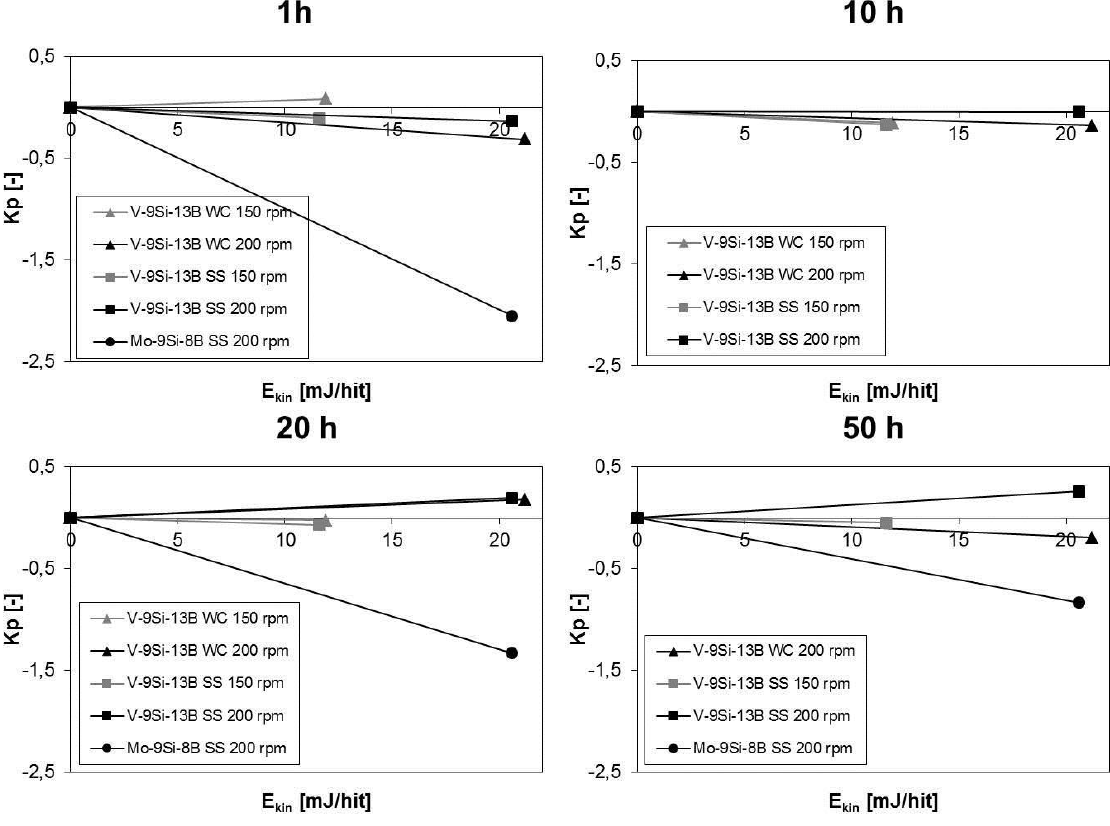
Figure 7. Comparison of the milling behavior of V-9Si-13B and Mo-9Si-8B alloys depending on the duration of milling and the impact energy.